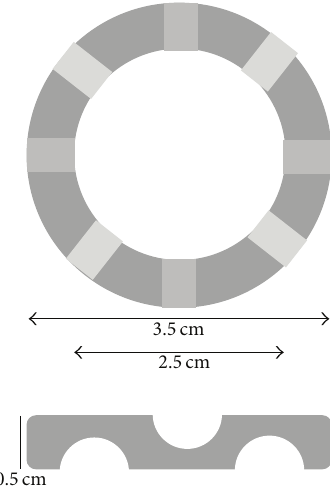
Figure 2: Description of the support device used. This support was previously used by many research teams [2, 4, 6, 8, 9]. It is a plastic ring made with Plexiglas with an outer diameter of 35 mm and an inner diameter of 25 mm. Its height is 5 mm. Eight channels of 2.5 mm of height (depicted in lighter greys) were carved in the plastic (4 in the upper face, 4 in the lower face) at an equal